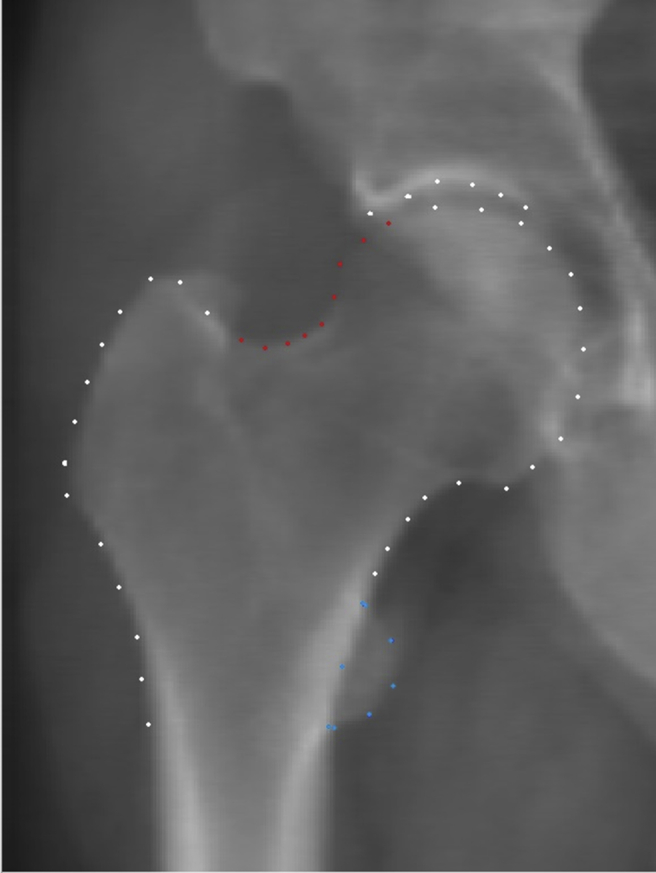
An example DXA image, This is a DXA image taken from the MrOS cohort. All the 53 points used for the SSM are marked on the image (combination of all white, red and blue points). Subregional models were composed of a smaller selection of points, the cam-type model comprising the red points and the lesser trochanter model comprising the blue points.